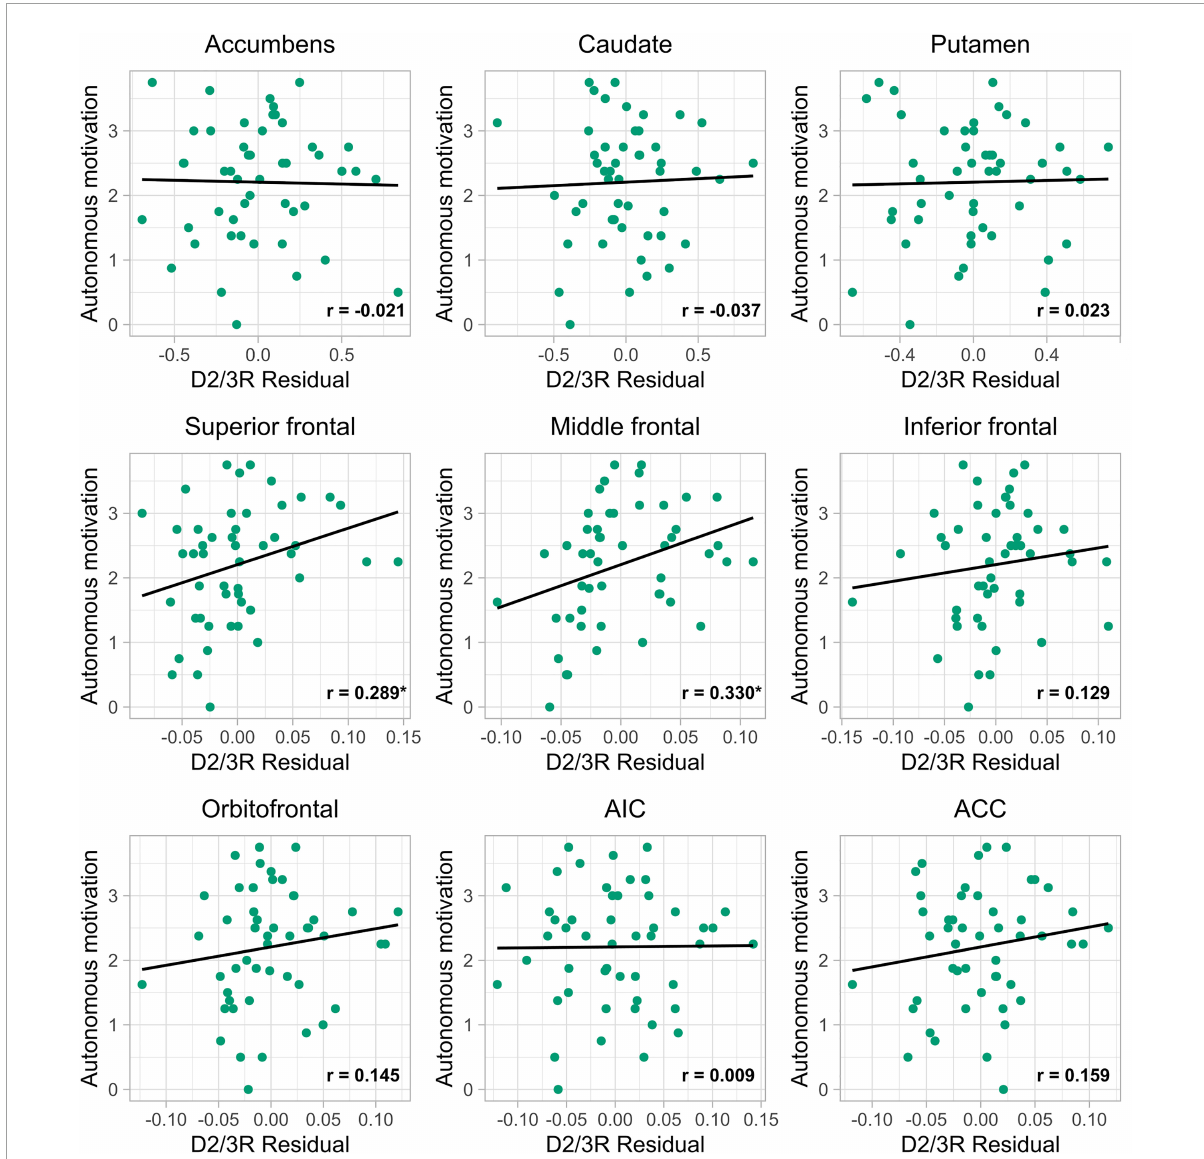
FIGURE2 Scatterplots of D2/3R availability within each ROI and autonomous motivation. Self-reported autonomous motivation along the y -axis, and the residual (controlling for structural ROI volume) dopamine D2/3-receptor availability (D2/3R residual) estimated with [ 11 C]-raclopride positron emission tomography (PET) along the x -axis. Nucleus accumbens (accumbens), caudate nucleus (caudate), superior frontal gyrus (superior frontal), middle frontal gyrus (middle frontal), inferior frontal gyrus (inferior frontal), orbitofrontal gyrus (orbitofrontal), anterior insular cortex (AIC), anterior cingulate cortex (ACC). *If p <